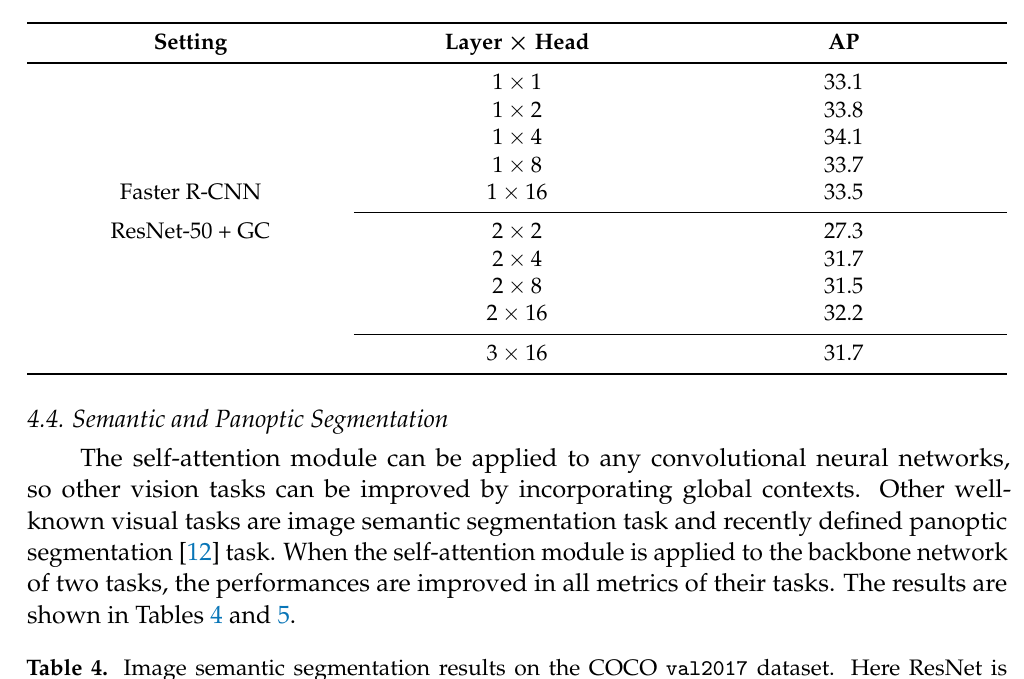
Table 3. Results using Faster R-CNN [7] on the COCO val2017 dataset varying a number of self- attention heads.